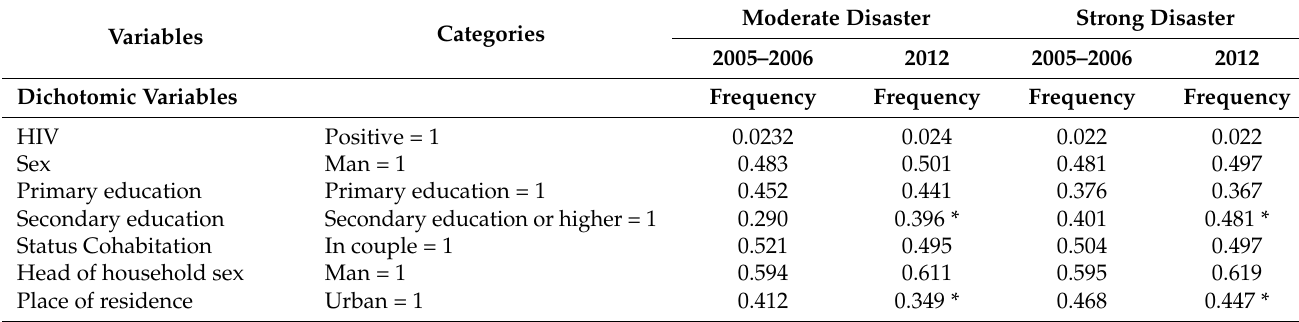
Table 2. Descriptive statistics of the